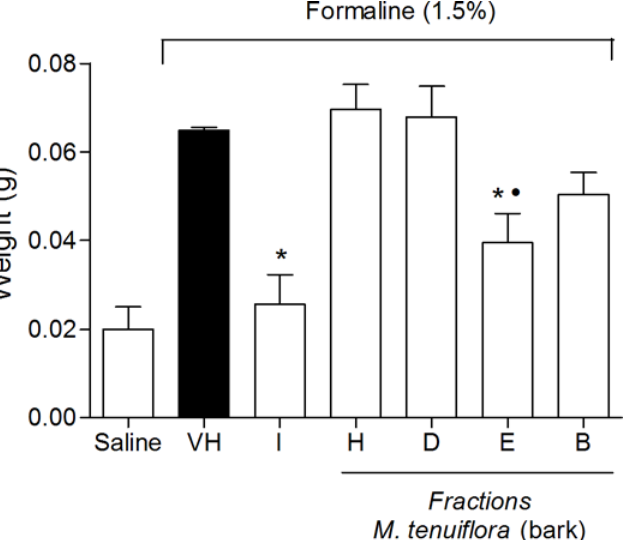
Fig 13. Effect of fractions of H-hexane, D-DCM, E-EtOAc and B-BuOH at 100 mg/kg of M . tenuiflora bark extract on paw edema after administration of formalin 1.5% (i.pl). VH is the vehicle group (negative control). Indomethacin (I, 10 mg/kg, i.p.) was the positive control group. Results are presented as mean ± S. D. (n = 8). Statistical significance was calculated by ANOVA followed by Bonferroni's test. * P < 0.05 compared to the vehicle-negative control treated group. (cid:129) P > 0.05 compared to indomethacin-treated group.